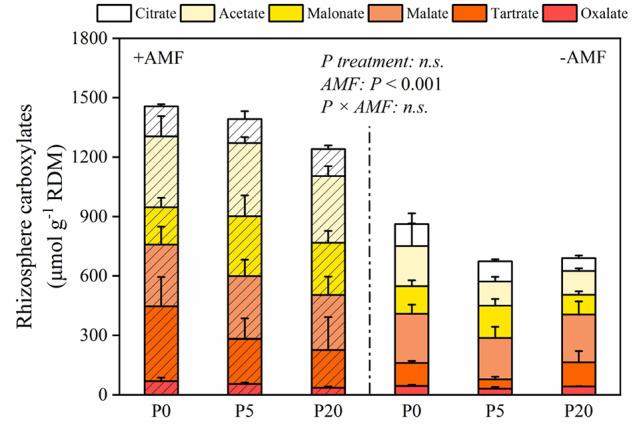
The amount of carboxylates relative to root dry mass. Data are presented as means ± S.E. (n = 4). Two-way ANOVA and Tukey’s test were performed for each AMF treatment (+AMF and −AMF) and P treatments (P0, P5, and P20). ANOVA P-values are indicated on the graph.